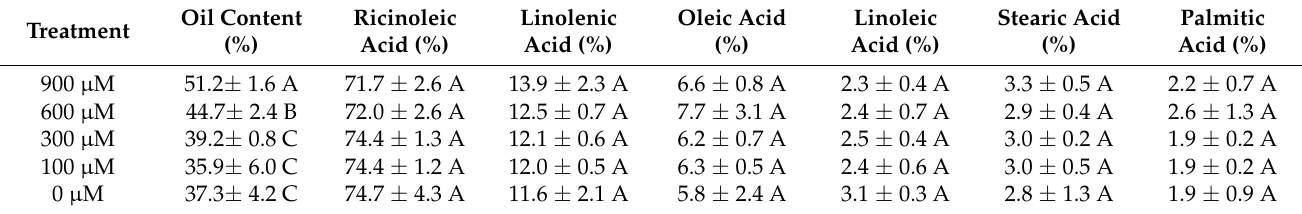
Table 2. Fatty acid and oil content of Ricinus communis plants treated with salicylic acid at different